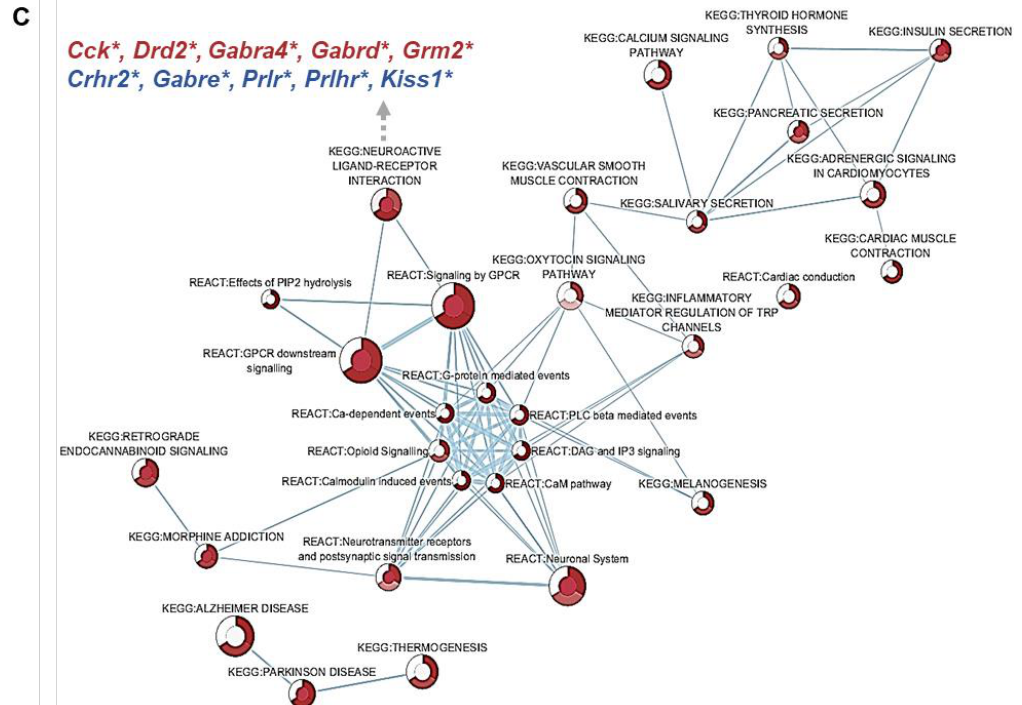
Figure 3. ( A ) Gene set enrichment legend, ( B ) Gene ontology (GO) and ( C ) Kyoto Encyclopedia of Genes and Genomes (KEGG) and Reactome pathways from custom gene set collections. Legend shows enrichment tests were run for gene sets enriched in “up-regulated”, “down-regulated” or “up- and down-regulated (i.e., differentially expressed)” genes in 5X-MTHF compared to 5X-FA dams using Goseq. Node size is proportional to the number of genes in the pathway set, and the connecting line thickness is proportional to the number of identical genes in connected sets. Outer node colors represent the FDR with multiple test correction (BH, Benjamini-Hochberg’s procedure). An FDR ≤ 0.1 and p ≤ 0.005 was used for enrichment analyses. Genes of interests (*) were validated by qRT-PCR at birth and post-weaning. Red font indicates if the gene was up-regulated and blue font indicates down-regulated genes. The center node color represents the number of identical genes that were from this validated gene list by qRT-PCR that are enriched in other pathways, with 10 being the maximum number of validated genes in a single pathway. Gene set clusters from GO are shown with representative cluster terms. Validated Gene Abbreviations: Cck , cholecystokinin; Crh2 , corticotropin-releasing hormone receptor 2; Esr1 , estrogen receptor 1; Gaba4a , gamma-aminobutyric acid type A (Gaba) receptor alpha; Gabrd , gaba receptor delta; Gabre , gaba